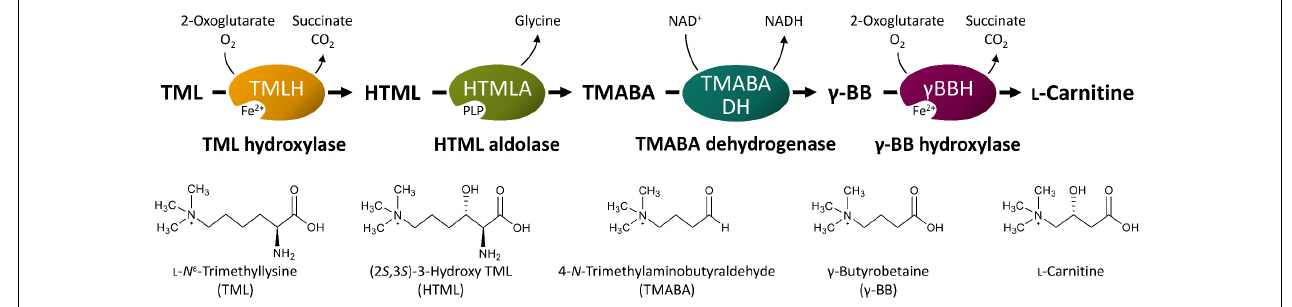
FIGURE 1 | Schematic illustration of L -carnitine synthesis from the precursor TML. PLP, pyridoxal 5 (cid:48) -phosphate; NAD + , nicotinamide adenine dinucleotide (oxidized form); NADH, nicotinamide adenine dinucleotide (reduced form). Other abbreviated substances are written in full in the bottom of the figure. Modified from Strijbis et al.